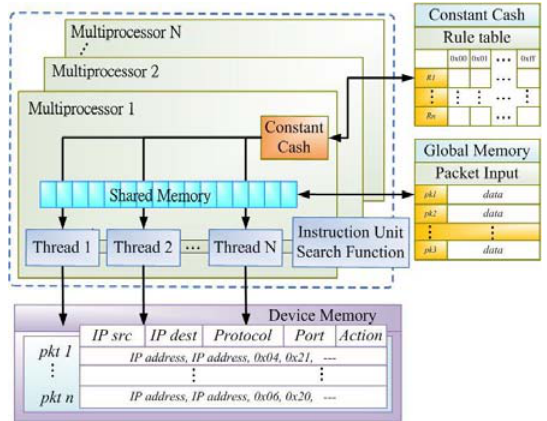
Fig. 3. Streaming approach on CUDA.